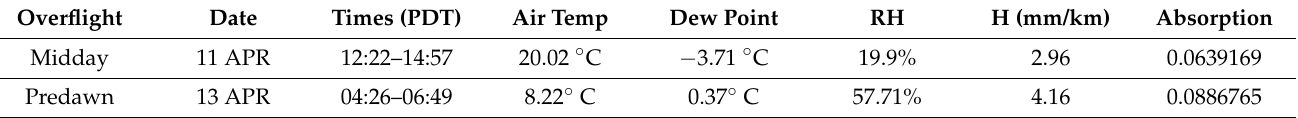
results presented in this paper should be robust. Table A1. 2011 overflight atmospheric conditions with air temperature and dew point estimated using PRISM data [105]. Overflight